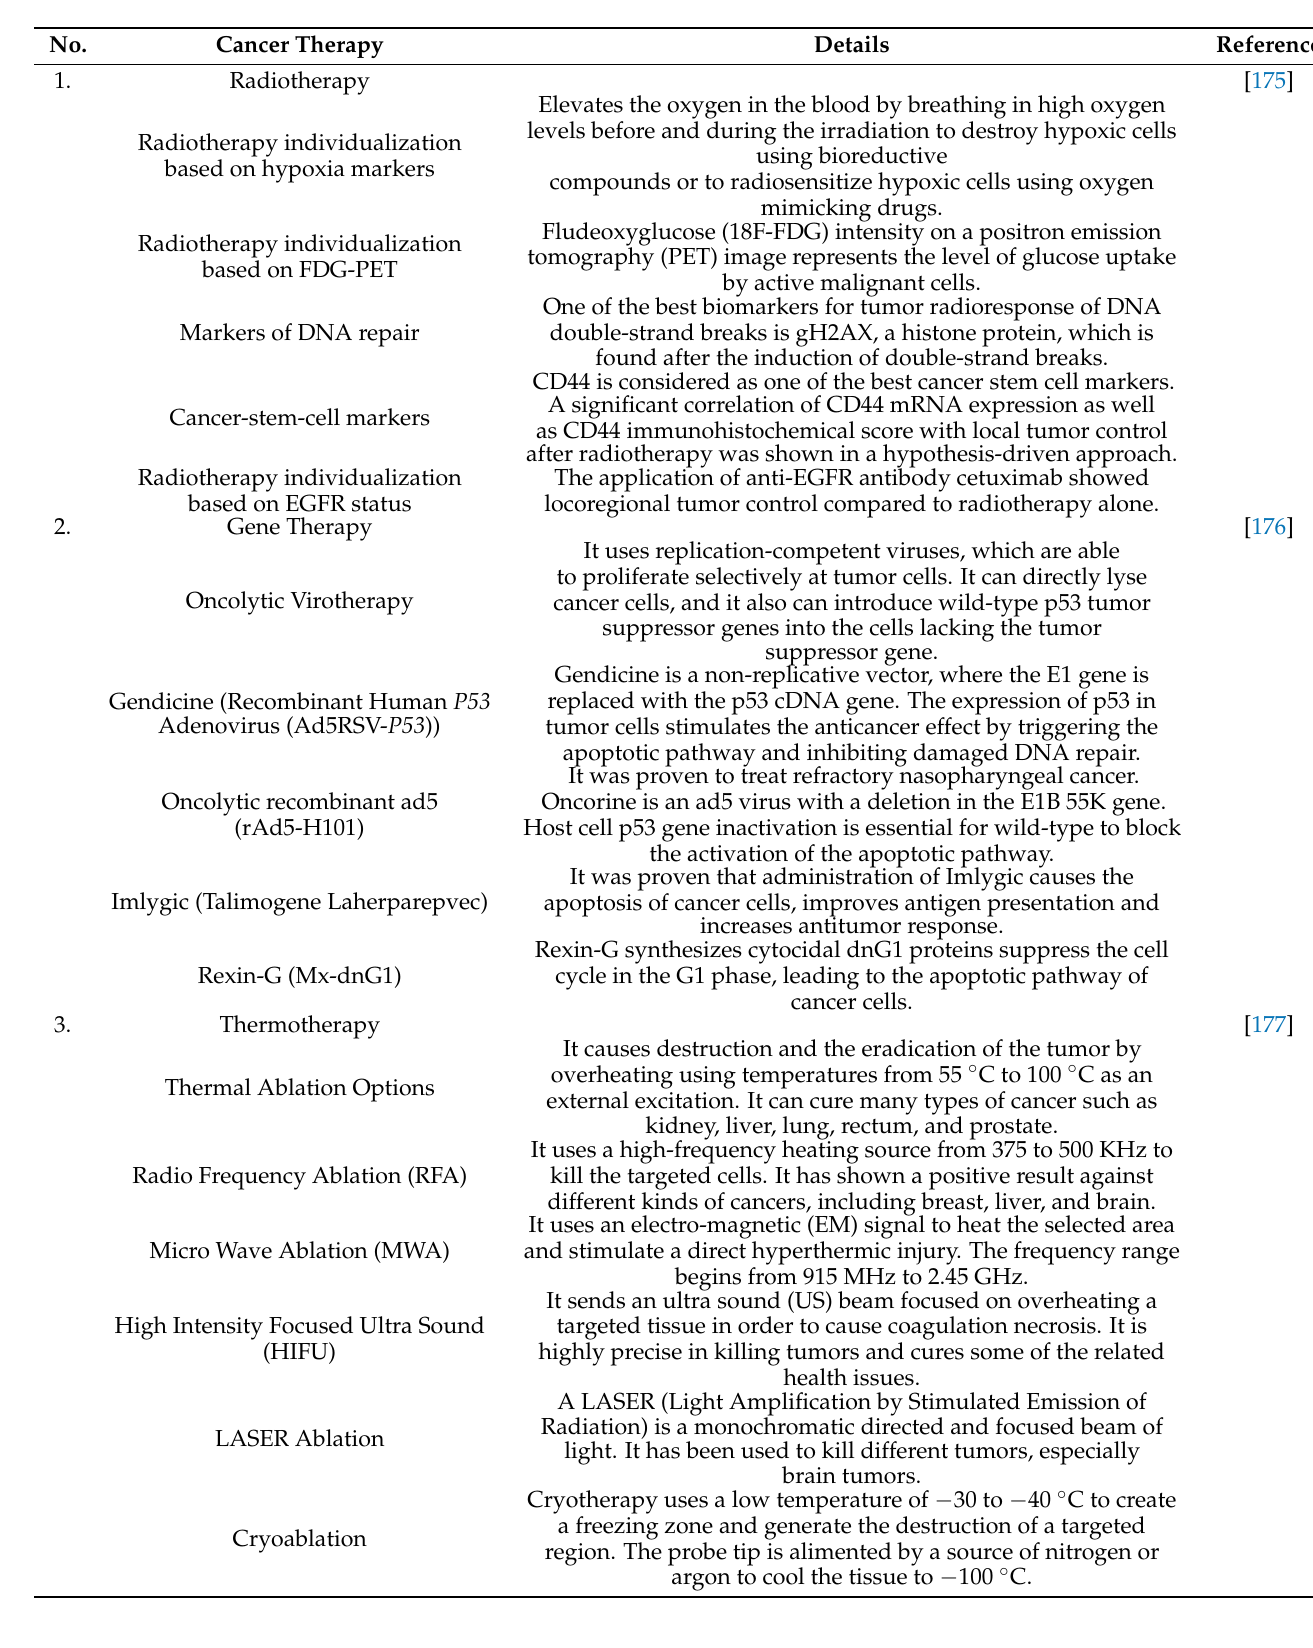
Table 3. List of various treatment modalities for